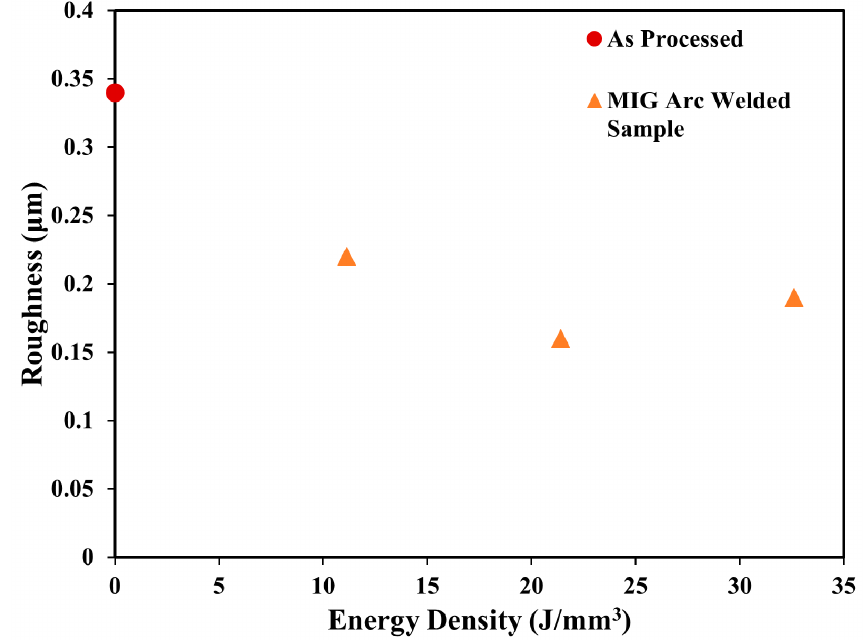
Figure 4. The relationship between energy density and average roughness ( R a ) for an MIG arc welded ER5356 aluminum alloy.